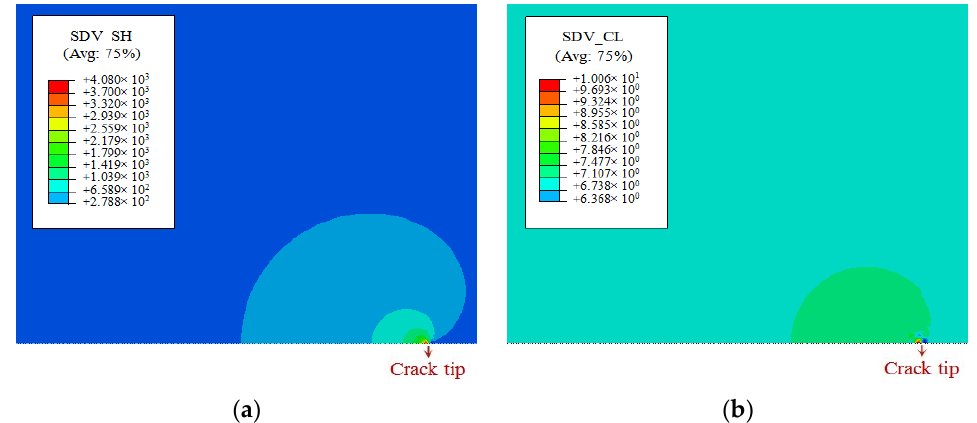
Figure 8. ( a ) Hydrostatic stress and ( b ) hydrogen concentration contours near the crack tip at u = 0.16 mm for C 0 = 7.0 ppm.